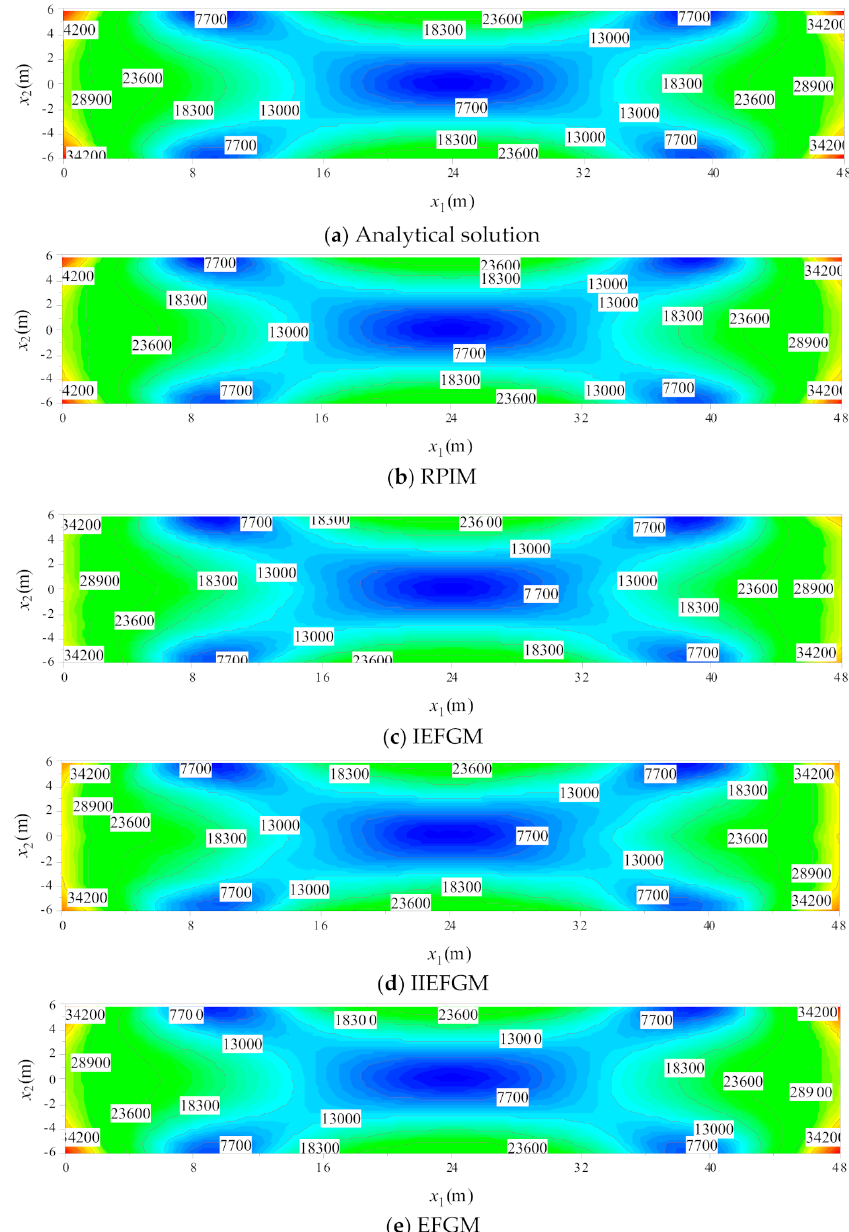
Figure 4. Contour of the Von Mises stress of the clamped-clamped